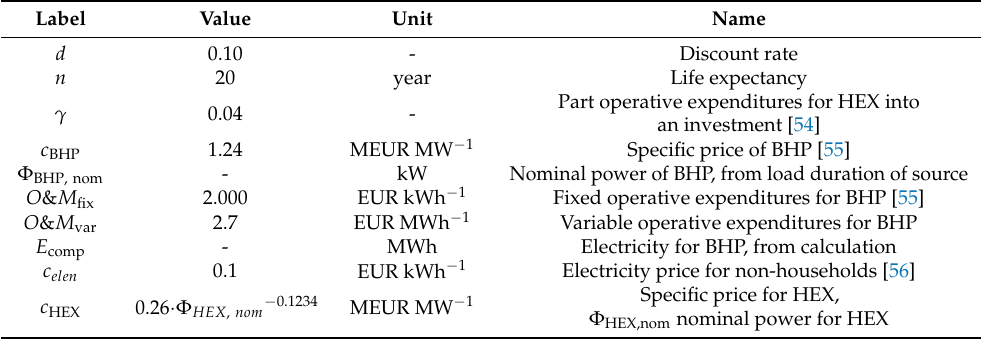
Table 5. Input data for techno-economic